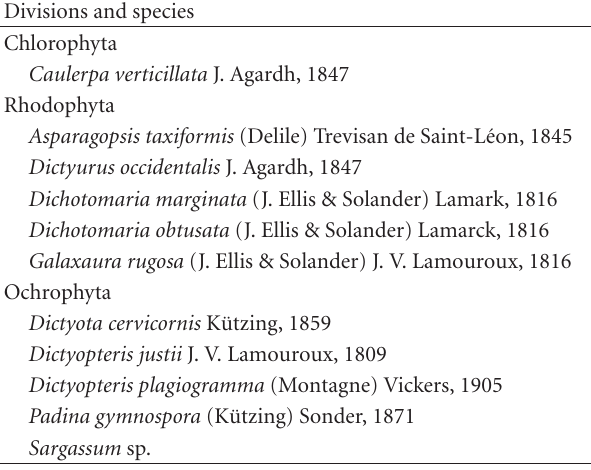
Table 1: Classification for the eleven species of seaweeds from Fernando de Noronha archipelago in northeastern Brazil analyzed in this study.